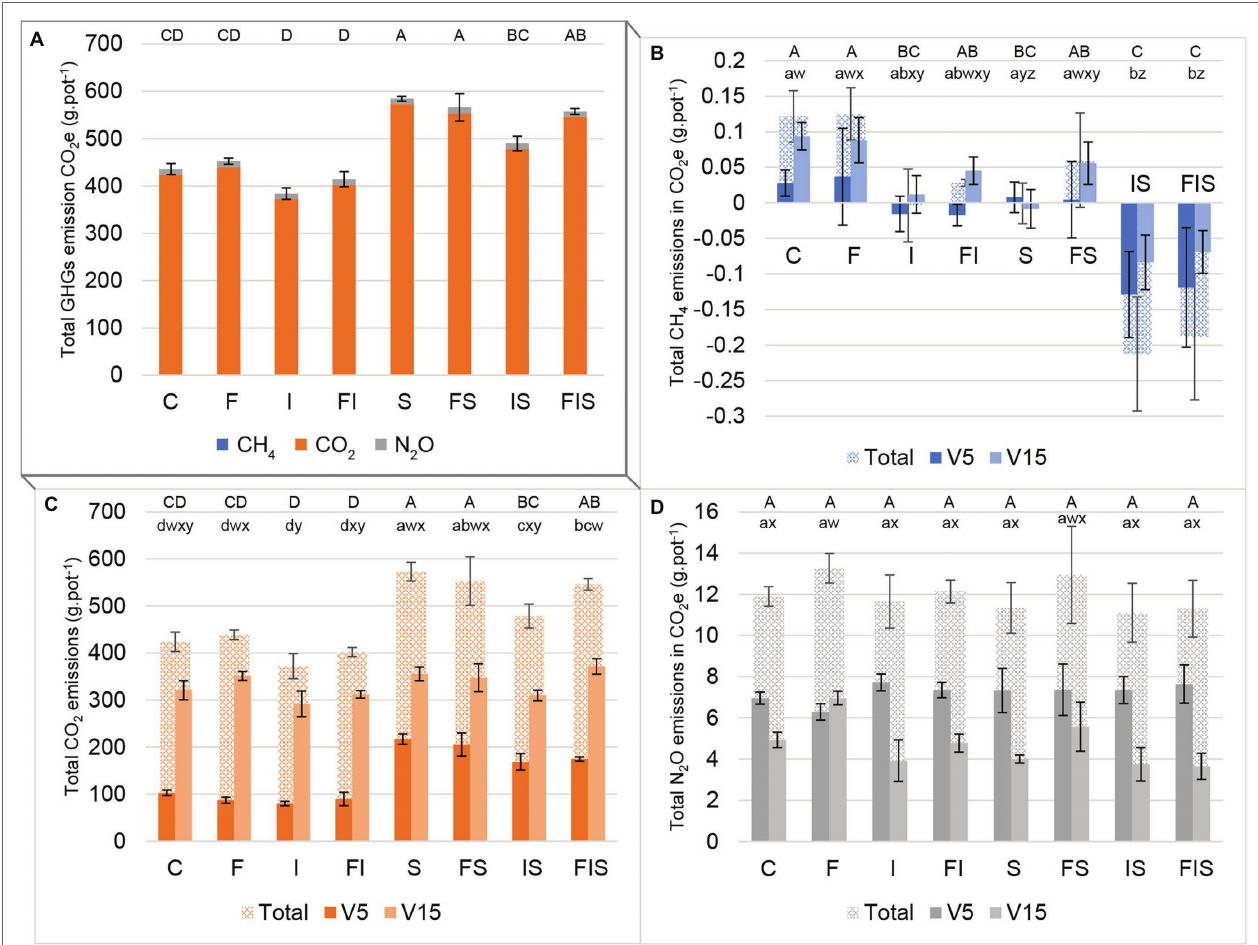
FIGURE 2 | Emissions in carbon dioxide equivalent (CO 2 equivalent) from the maize soil-rhizosphere experiment: (A) sum of all three main GHGs, (B) methane (CH 4 ), (C) carbon dioxide (CO 2 ), and (D) nitrous oxide (N 2 O). Bars with the same letter are not significantly different ( p < 0.05). Three groups of series of letters compare treatments: uppercase letters (ABCD) on the top of bars compare differences among total emissions of the entire experiment; lowercase letters close to bars compare each stage period ( abcd for V5 and wxyz for V15). V5 includes accumulated gas measurements before the rhizosphere sampling at V5, while V15 includes accumulated gas measurements between both rhizosphere sampling times (V5 and V15). Total bars are the sum of both periods (V5 and V15). Treatments: C, Control; F, Urea-topdressing fertilization at V5; I, A. brasilense inoculant on seeds sowing; FI, F + I; S, Maize stover coverage; FS, F + S; IS, I + S; FIS, F + I +